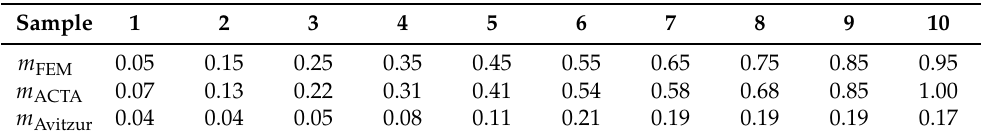
Table 4. The assigned ( m FEM ) and estimated friction factors of the ten samples used for the evaluation. The estimations for the Avitzur model are obtained from Equation (3) with its barreling parameter from Equation